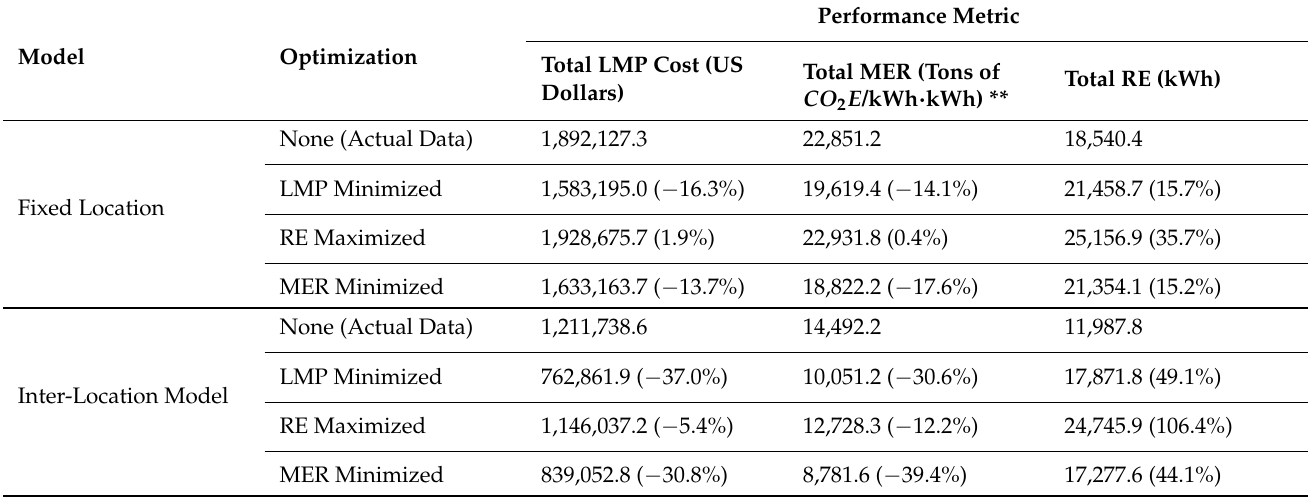
Table A1. Comprehensive comparison of optimization models and objective functions on their economic and environmen- tal